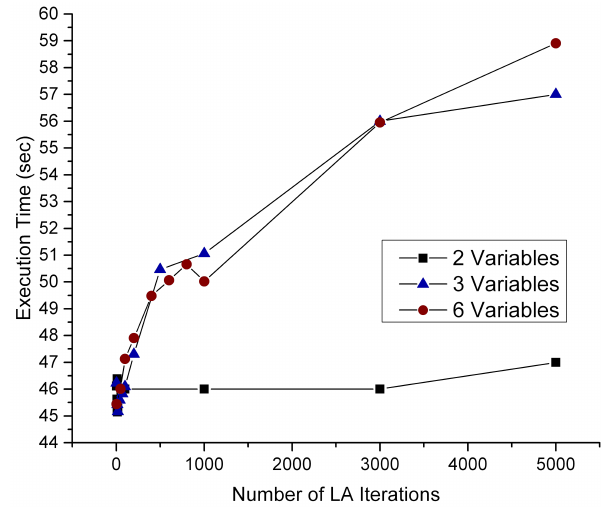
Figure 5. Execution time of Orion algorithm.